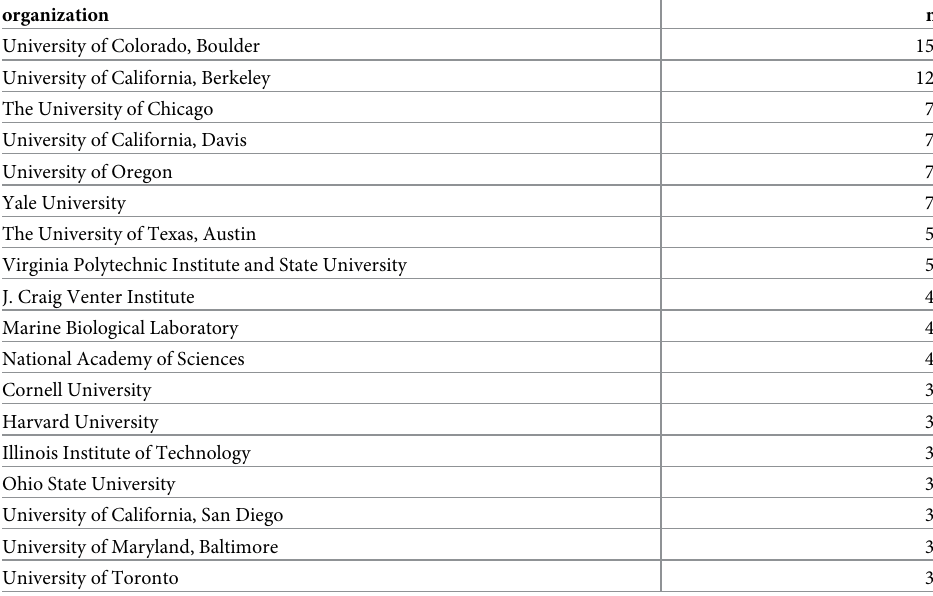
Table 1. Organizations that received 3 or more awards under the MoBE program. Awards include research funding as well as funds for meeting organization, data infrastructure development, outreach, and other categories. n: Number of awards received.